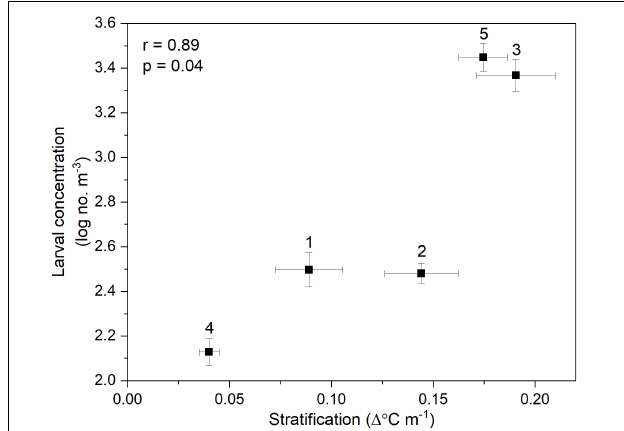
FIGURE 8 | Correlation between mean ( ± SE) thermal stratification and log-transformed total (sum of all depths) C. fissus larval concentrations for each cruise (numbers